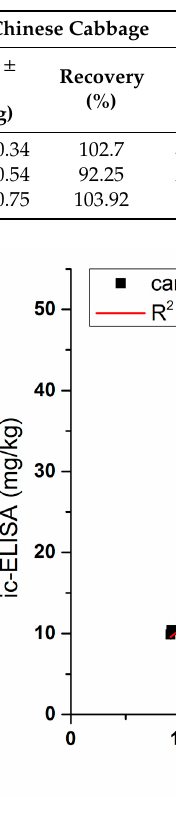
Figure 7. Correlations of analysis of samples spiked with carbofuran between Nb316-based ic-ELISA and UPLC–MS/MS.